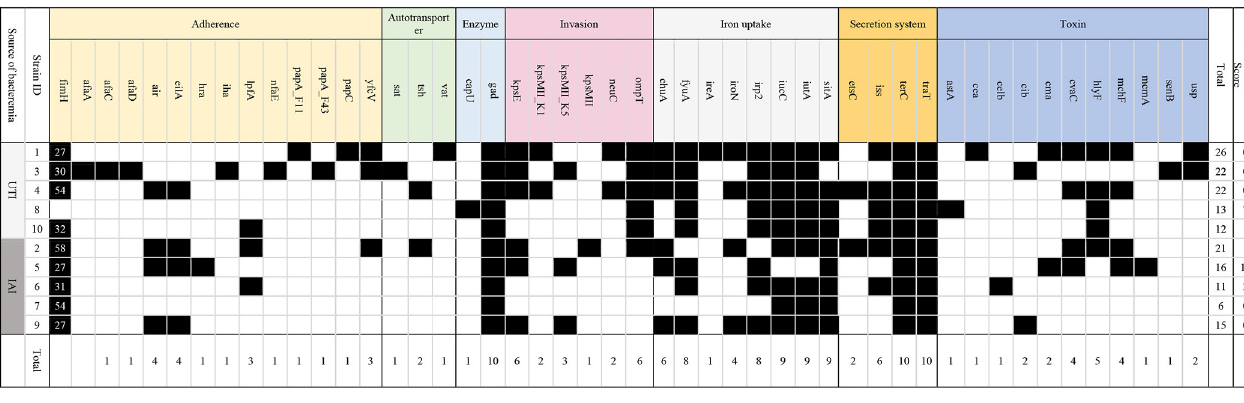
TABLE 4 | Heatmap presents in silico analyses of virulence